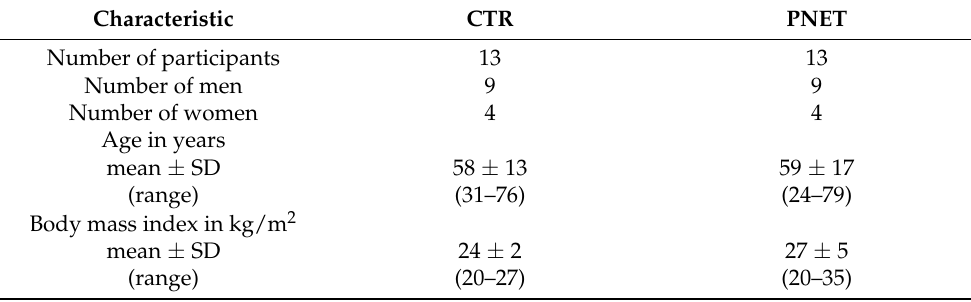
Table 1. Characteristics of the study population (CTR and PNET).